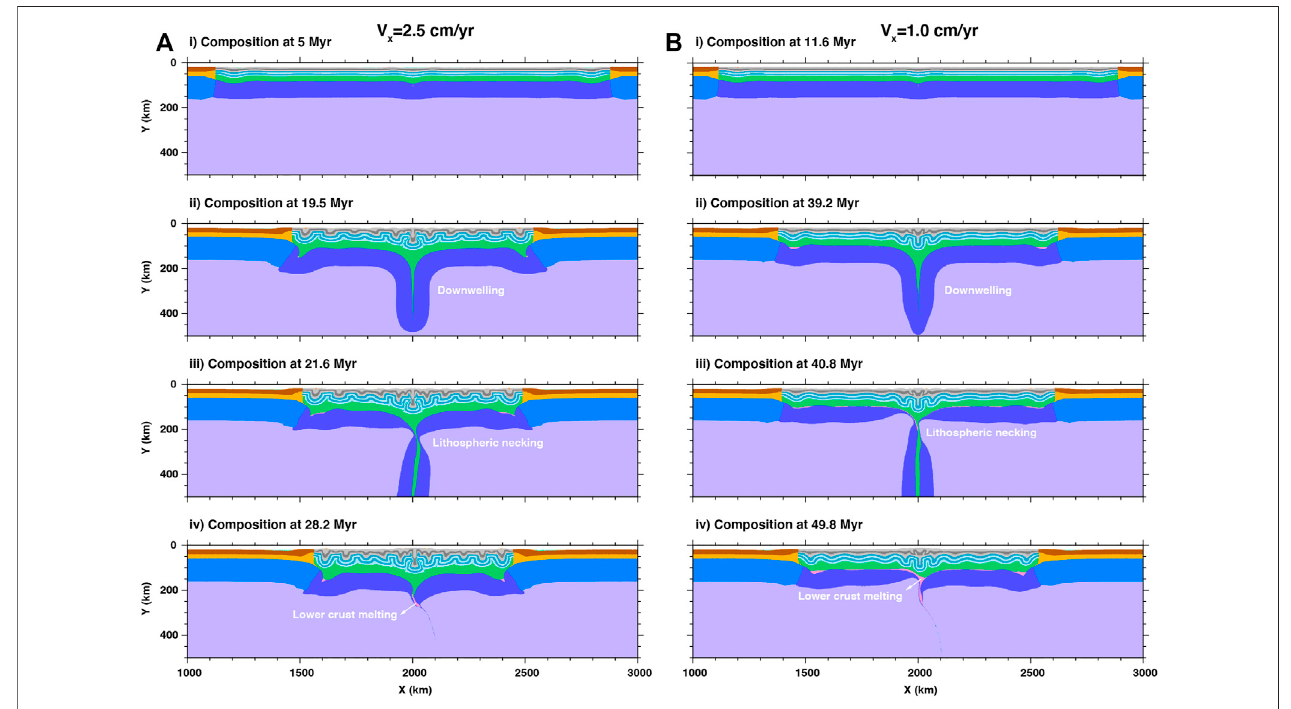
FIGURE 7 | Time evolutions of the models with different convergence rates. (A) fast convergence model (V x (cid:2) 2.5 cm/yr; see “ delb ” in Table 2 ), and (B) slow convergence model (V x (cid:2) 1.0 cm/yr; see “ delj ” in Table 2 ). The fl ow law of “ ma fi c granulite ” (Wang et al., 2012) is used for the orogen lower crust in these models.